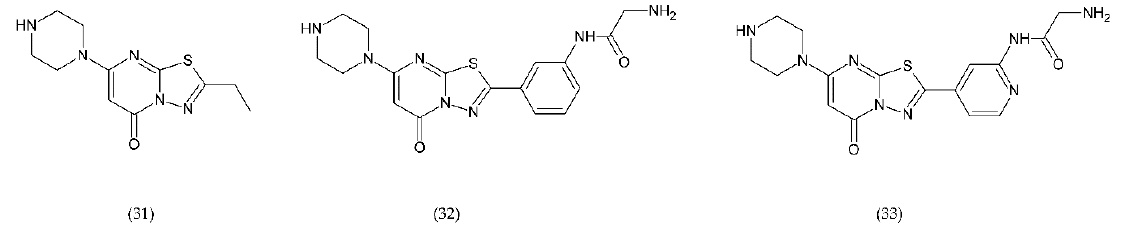
Figure 12. Chemical structures of RUC-1 (31), RUC-2 (32), RUC-4 (33).